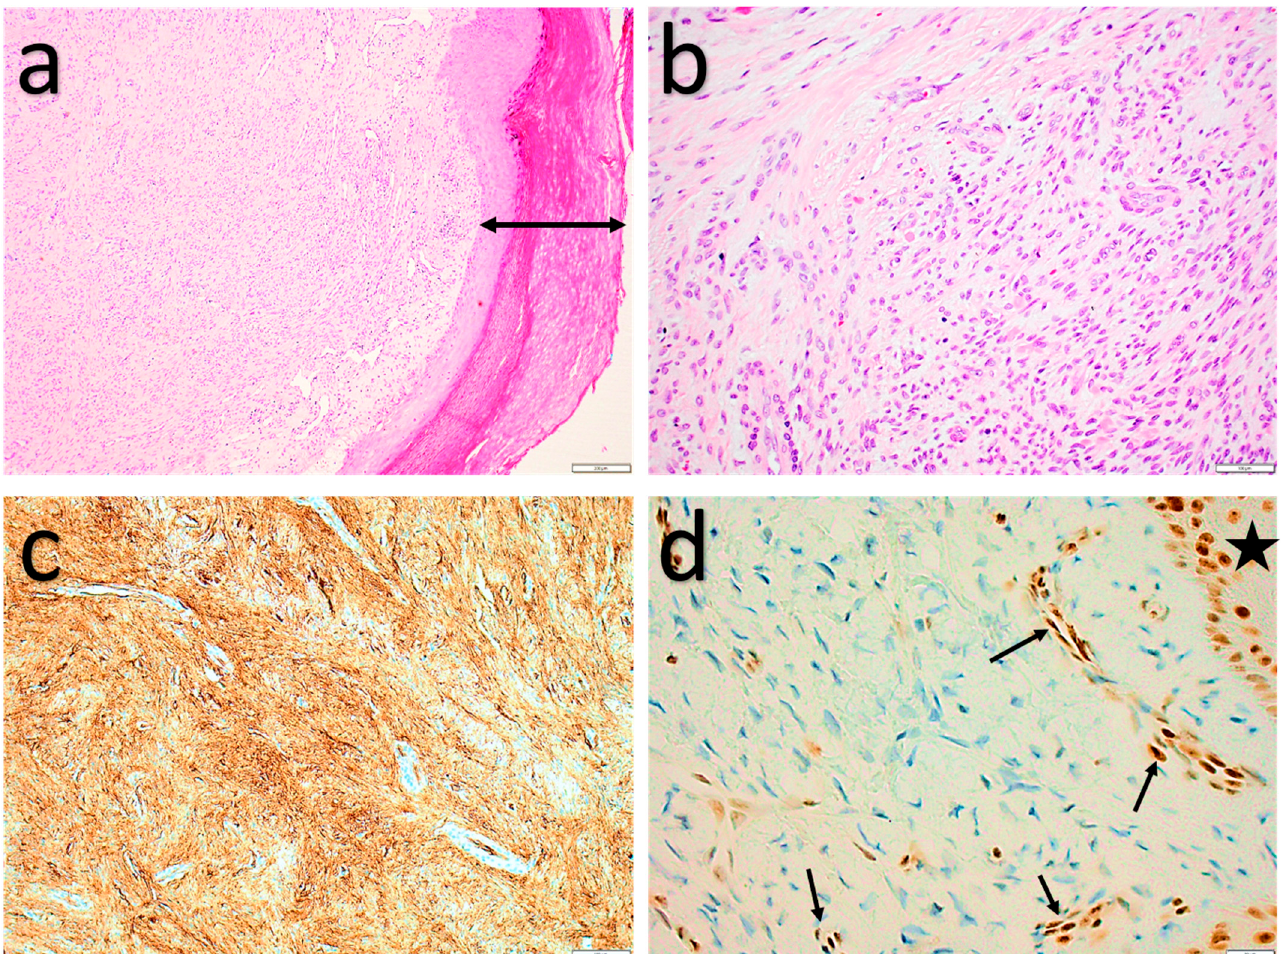
Figure 8. Acral fibromyxoma. ( a ) Superficial, dermal, bland fibromyxoid spindle cell lesion with hyperplasia of the overlying epidermis (double-headed arrow). ( b ) Bland spindled cells set in a fibrous and fibromyxoid stroma. ( c ) Strong, diffuse, cytoplasmatic CD34 expression. ( d ) Loss of nuclear Rb expression in the spindle cells and intact nuclear Rb expression in the endothelial cells (arrows) and epidermis (star).